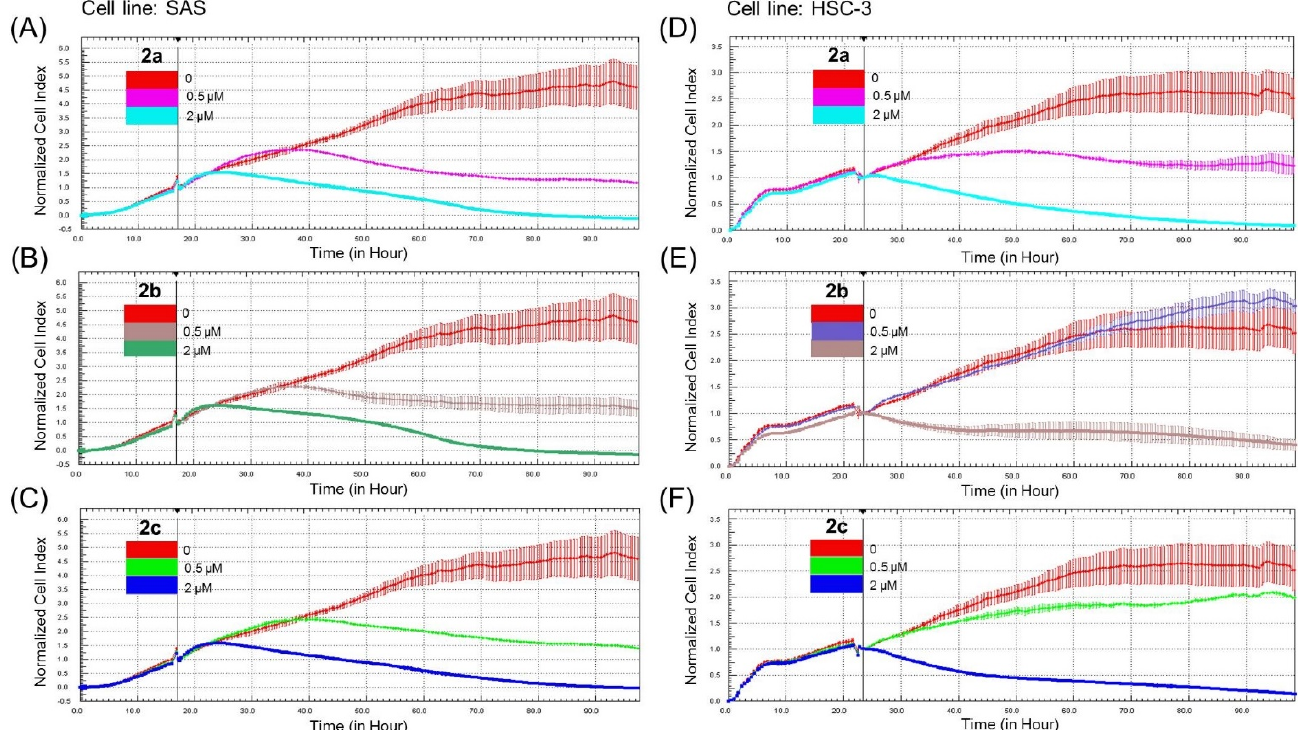
Figure 2. Bis(chloroacetamidino)heteroareneanthraquinones 2a – c attenuate the growth of oral cancer cells. Cell proliferation was dynamically monitored by impedance measurements in SAS ( A – C ) and HSC-3 ( D – F ) cells, as described in the Materials and Methods. Shown are normalized cell index values measured. Cells were treated with various concentrations of the studied derivatives 2a – c .